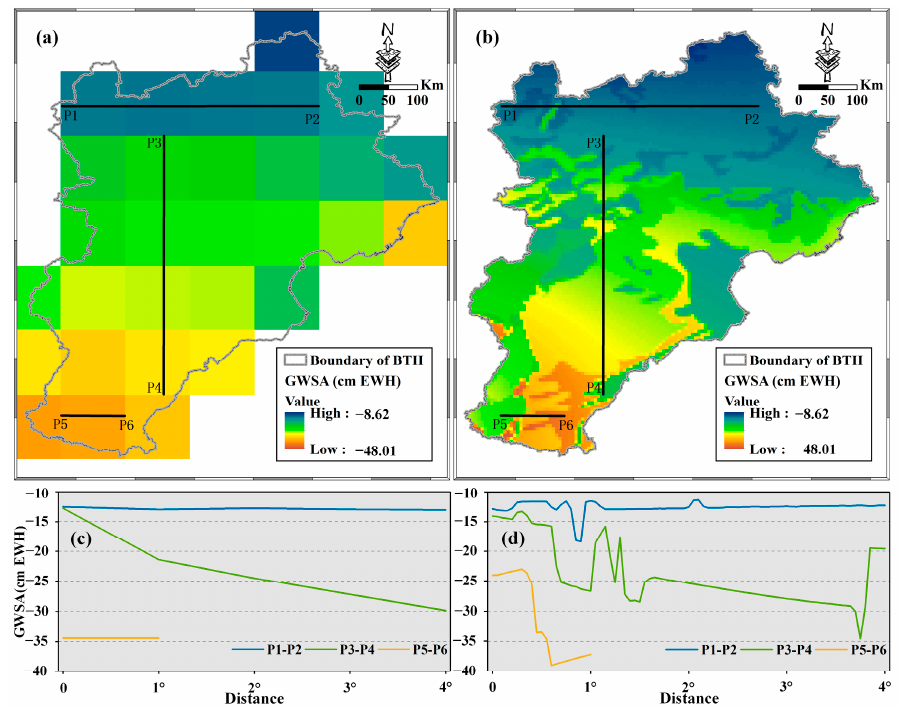
Figure 6. Comparison of GRACE-derived GWSA and downscaled GWSA at the resolution of 1° in the area for 2019. ( a , b ) represent the spatial distribution of GRACE-derived GWSA with the resolution of 1° and 0.05°, and ( c , d ) represent the change of GWSA in different transects with the resolution of 1° and 0.05°, respectively.